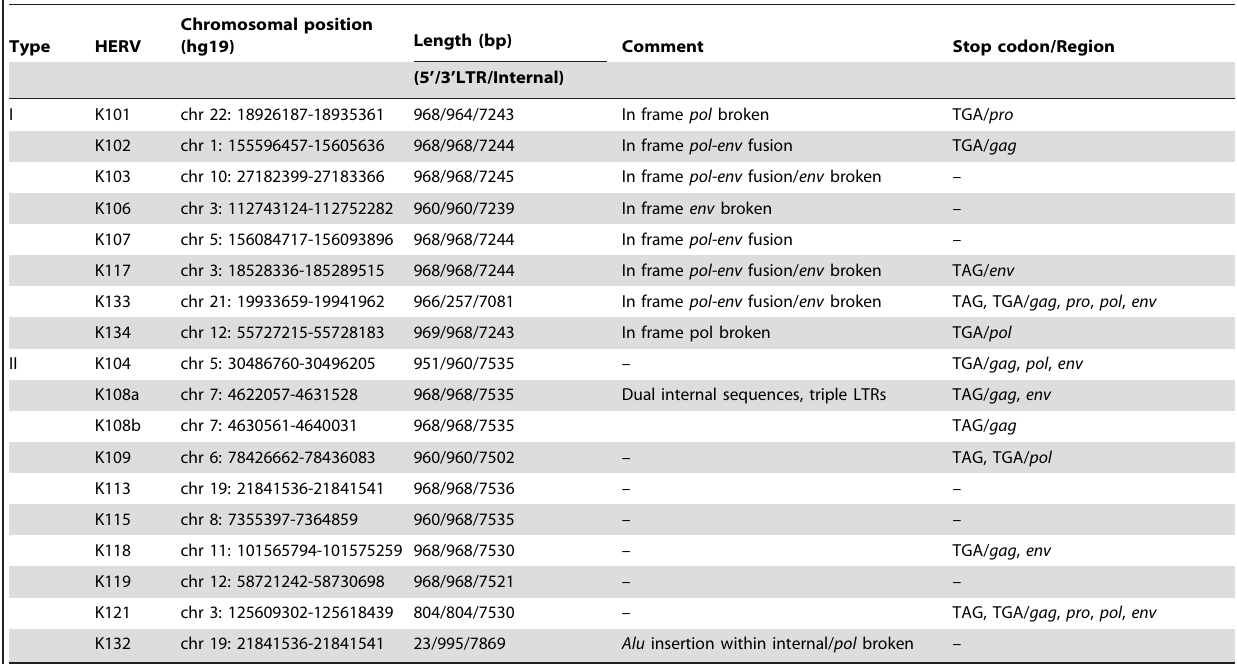
Table 2. The structural characterization of human-specific full-length HERV-K.